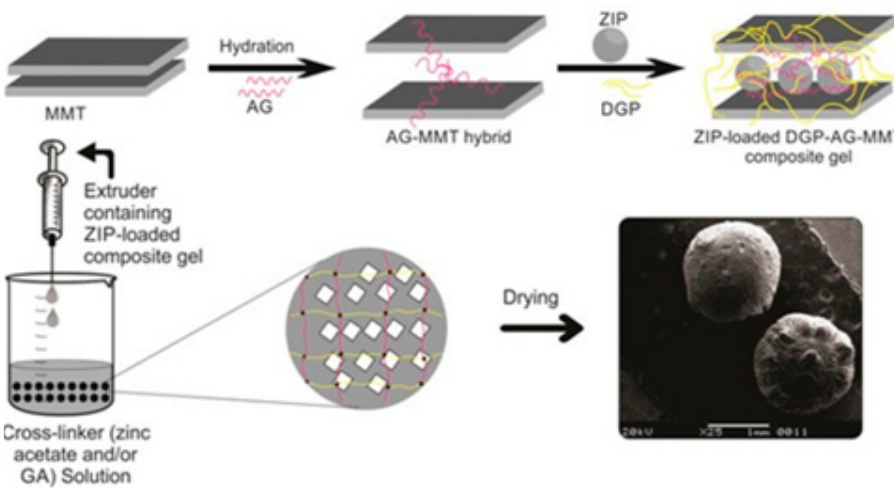
Figure 5. Scheme for the formation of Pec-based MMT hydrogels and ZIP loading. Reproduced with permission [56].